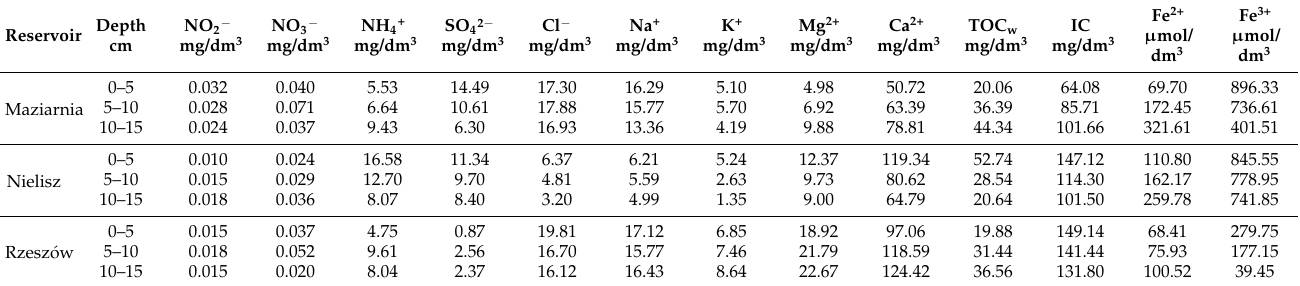
Table 3. Results obtained for the chemical parameters of pore water in the reservoirs